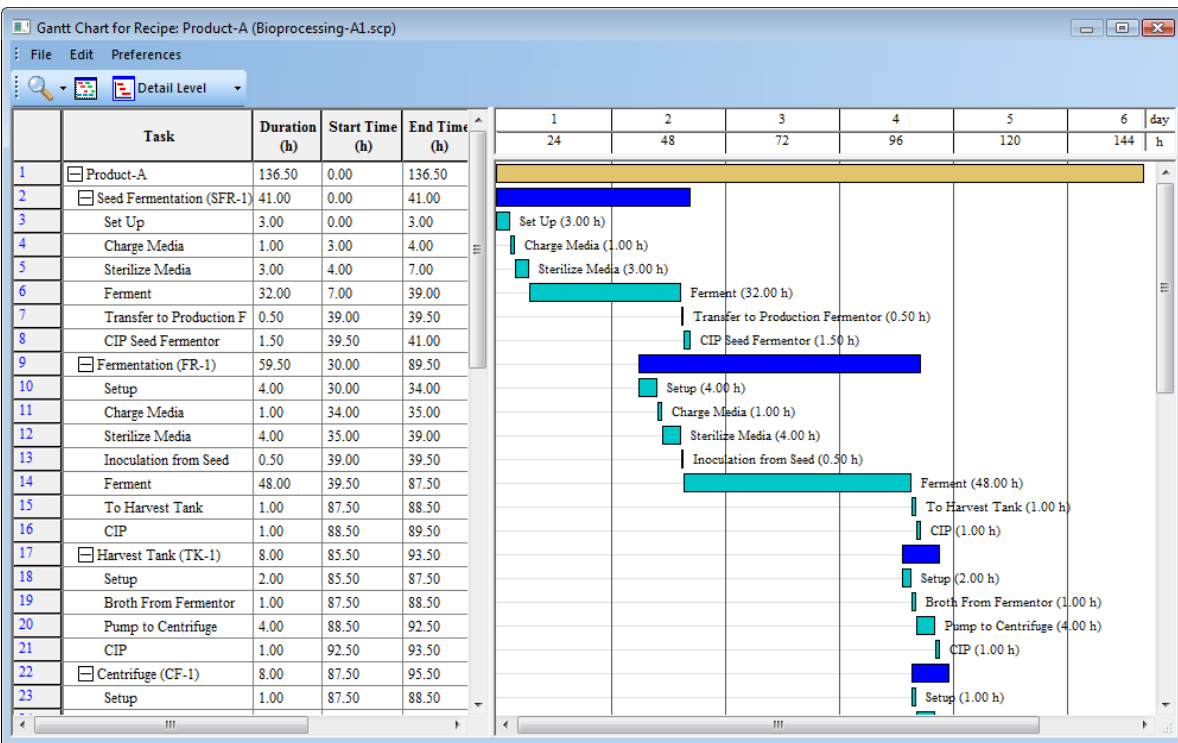
Figure 8. Recipe Gantt chart.